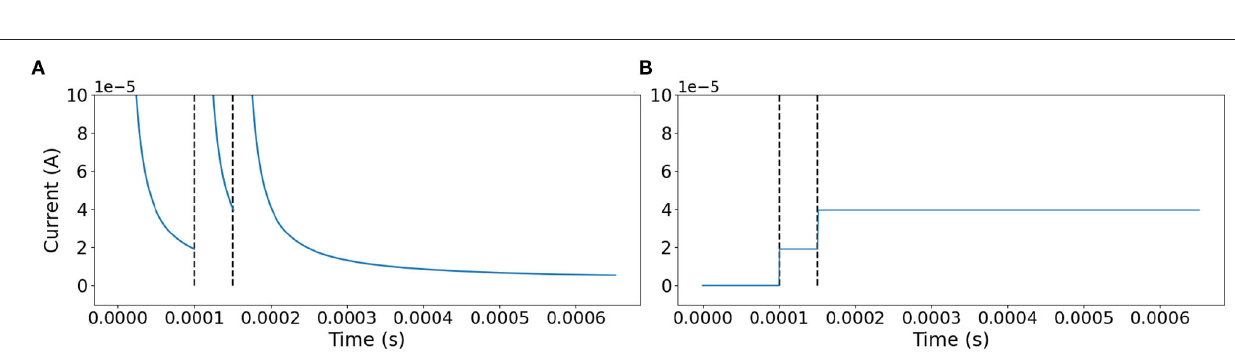
FIGURE 5 | Signal rebuild scheme. (A) Behavior of Equation (7) evaluated at each step of the simulation. (B) At each spike Equation (7) is evaluated with p equal to the time elapsed from the last spike, and the value is preserved until the next event is reached. The dotted line marks the time of two spikes.